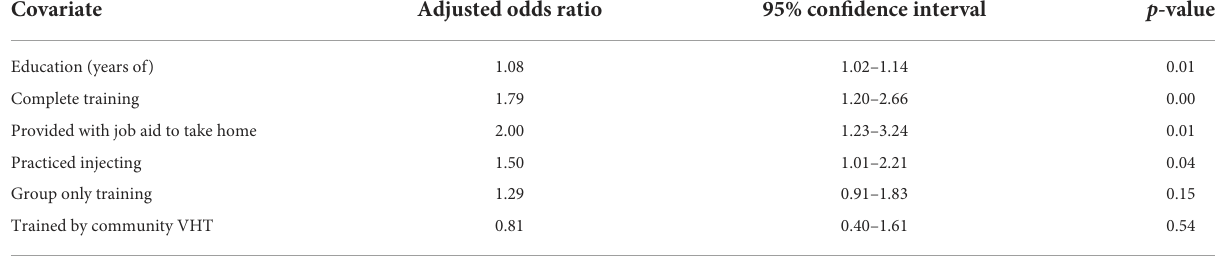
TABLE 3 Mixed effects multivariate logistic regression of injection proficiency.